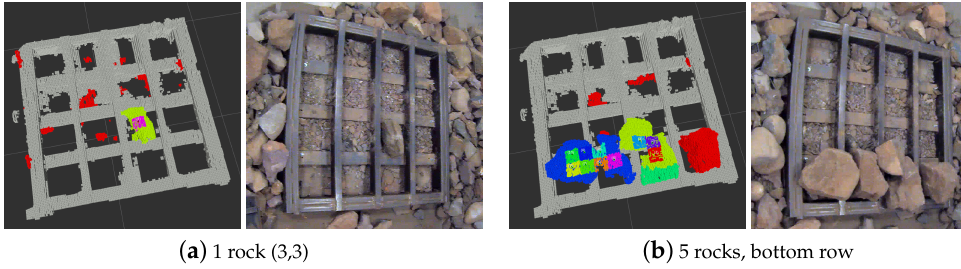
Figure 21. Examples of two of the performed experiments. ( a ) A single rock near the center of the grizzly, and ( b ), rocks occupying the cells of the bottom row of the